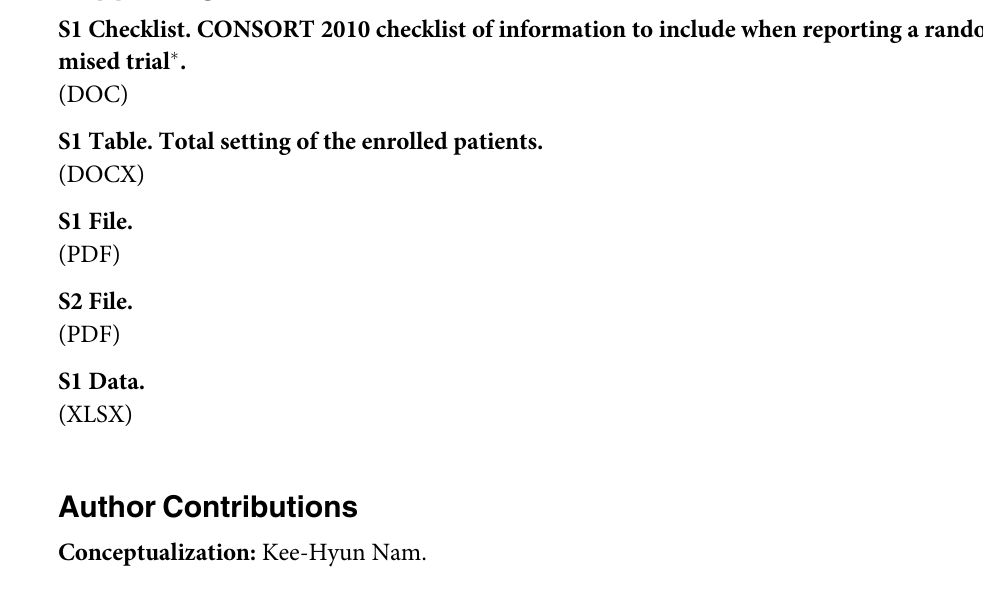
S1 Table. Total setting of the enrolled